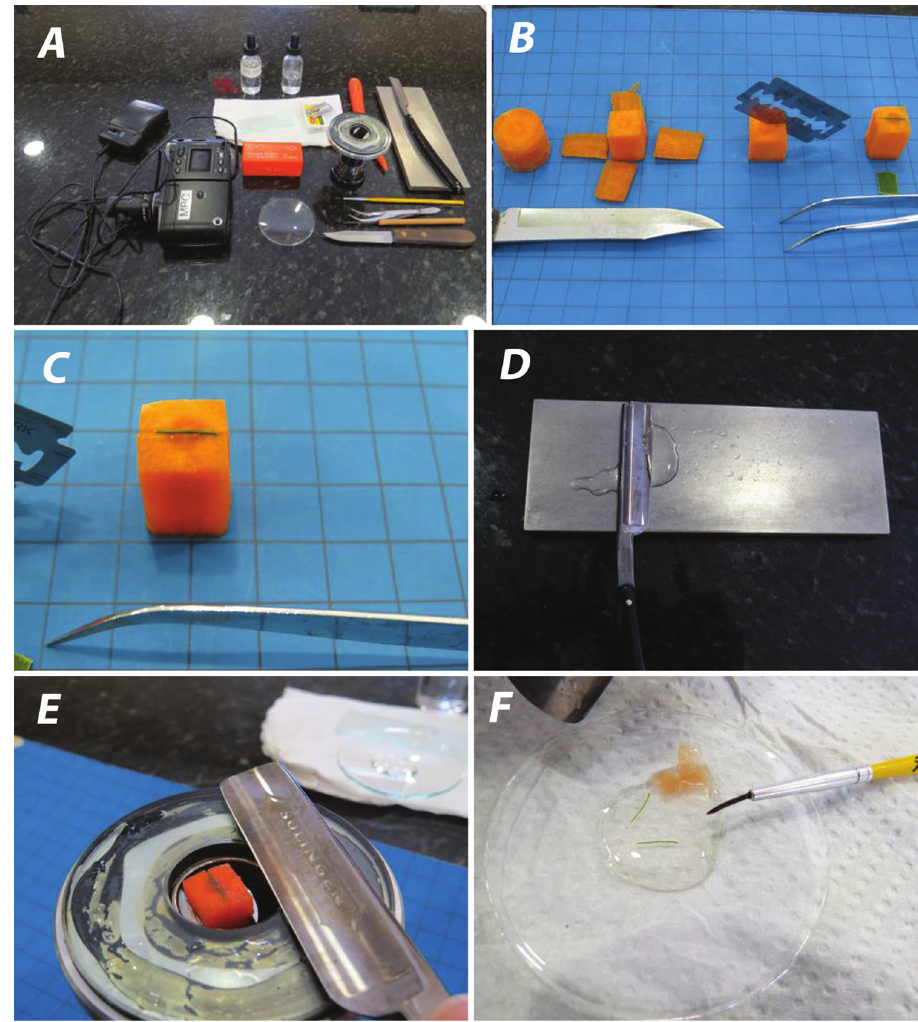
Figure 1. Materials and methods. A Materials used in making leaflet sections B Cutting carrot into a cube, slitting the cube and inserting the leaflet margin C Leaflet margin inserted in carrot cube ready for sectioning D Sharpening the straight razor on the wet stone E Clamping the carrot cube with leaflet margin into the hand microtome and preparing to section with the straight razor F Leaflet sections teased from the carrot into a watch glass with